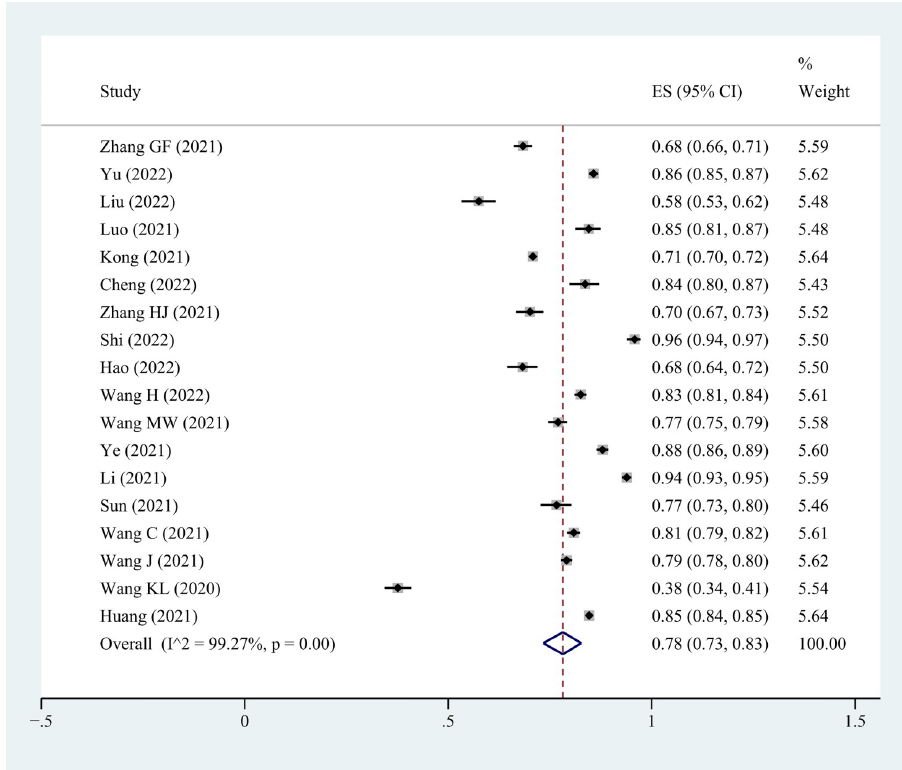
Fig 2. Forest plot showing COVID -19 vaccine acceptance rate among HCWs in